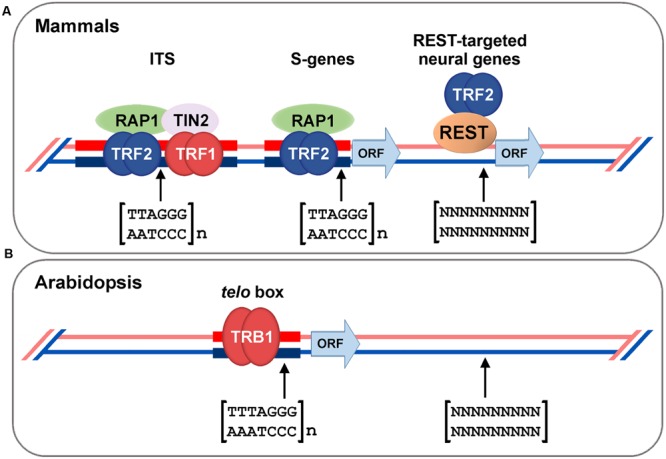
Association of shelterin proteins with extra-telomeric sequences. (A) Mammalian telomere-binding proteins TRF1/2, TIN2, or Rap1 associate not only with terminally localized telomeric repeats but also with interstitial telomeric sequences (ITS) and satellite repeats (Krutilina et al., 2001; Mignon-Ravix et al., 2002; Simonet et al., 2011; Yang et al., 2011). Mouse Rap1, together with TRF2, acts as a gene transcription regulator, including subtelomeric-gene (S-gene) silencing, and also binds to non-coding genomic regions enriched with TTAGGG repeats (Martinez et al., 2010). Moreover, TRF2 regulates neuronal genes by interaction of TRF2 with repressor element 1-silencing transcription factor (REST; Zhang et al., 2008). (B)
Arabidopsis TRB1 protein was found not only as a component of the telomeric interactome (Schrumpfova et al., 2014), but also as a factor associated with 5′ flanking regions (mostly comprising the telo box) of translation machinery genes (Schrumpfova et al., 2016; Zhou et al., 2016).